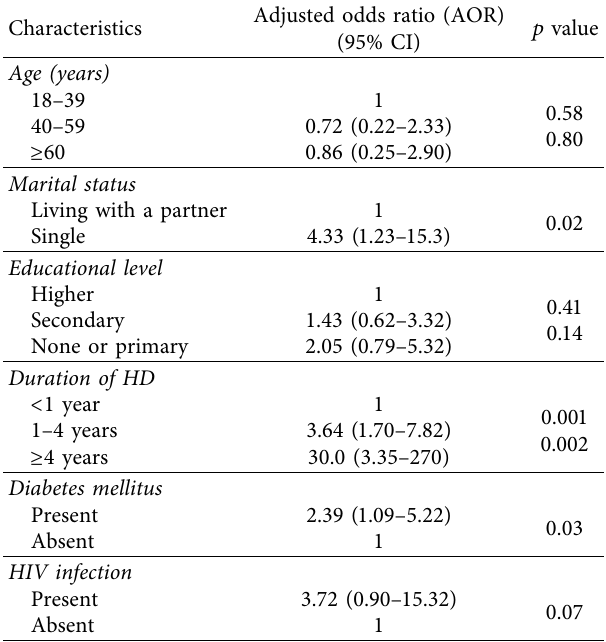
Table 3: Multivariate logistic regression analysis to show associated risk factors for malnutrition among hemodialysis patients ( N � 160).